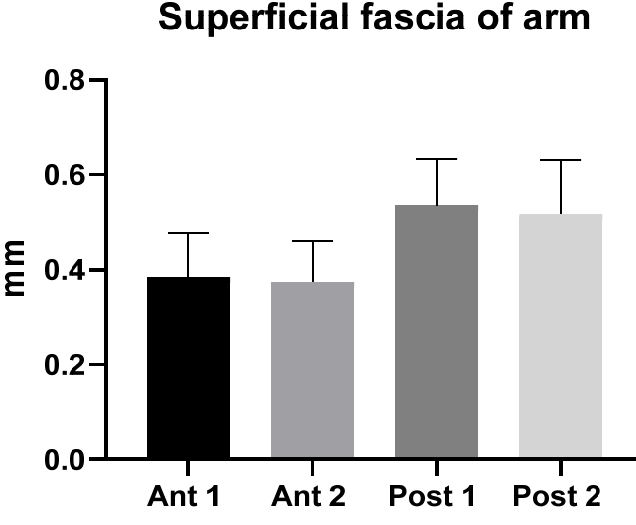
Figure 3. Ultrasound thickness measurements of the superficial fascia of the arm. The superficial fascia was thicker ( p < 0.0001) in the posterior region (0.53 ± 0.10 mm) than in the anterior region (0.40 ± 0.10 mm), whilst there was no difference between the proximal and the distal levels (Table 3). Moreover, no differences were found between right and left sides for all regions and levels ( p > 0.05). The findings for the comparisons within different regions/levels of the superficial fascia are reported in Table 3. According to Tukey’s multiple comparison test, the comparison between superficial fascia thickness among various levels/regions of the arm showed statistically significant differences (Table 3). Table 3. Ultrasound measurements within different regions/levels of the superficial fascia of the arm. Statistically significant results are showed in bold. ****: p < 0.0001. ns: not statistically significant.